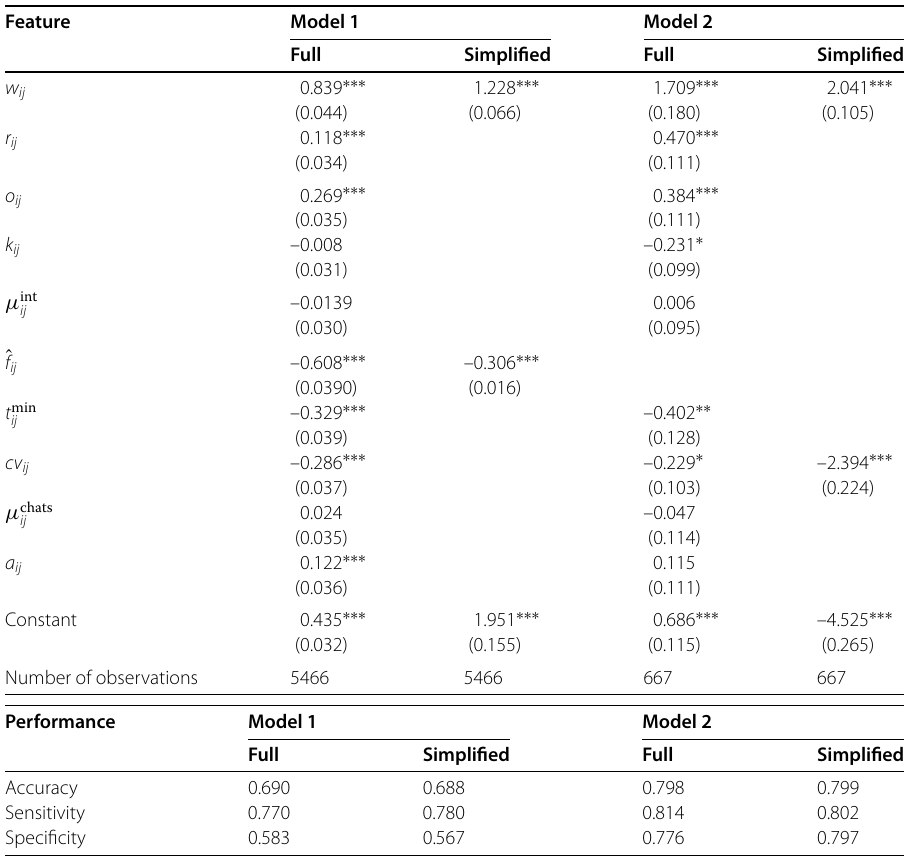
Table 4 Regression results for the tie persistence using generalized linear models for the two prediction models in the Facebook